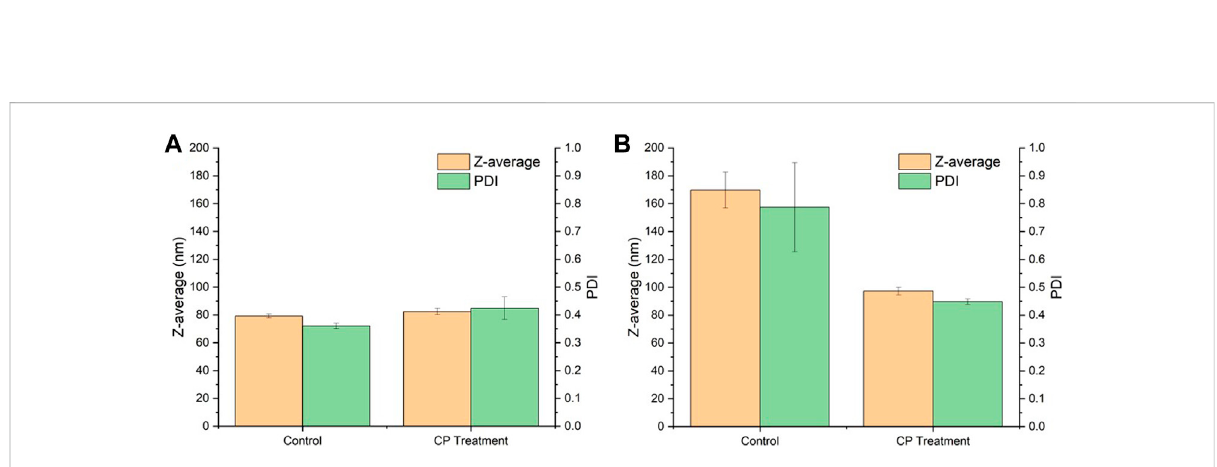
FIGURE 4 Effect of cold plasma treatment on the particle size of SNPs. (A) Before drying. (B) After